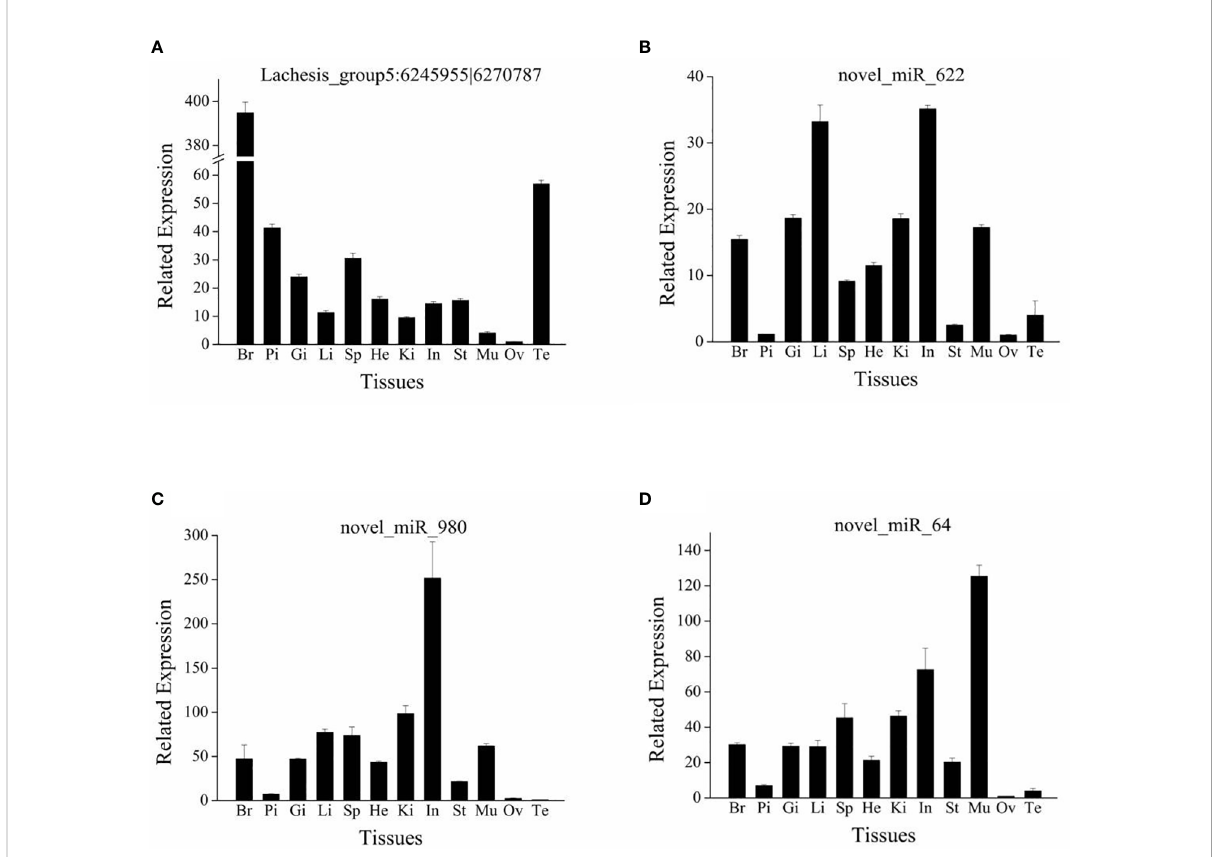
FIGURE 7 Tissue distribution of circRNA Lachesis_group5:6245955|6270787 (A) and three miRNAs novel_miR_622 (B) , novel_miR_980 (C) , and novel_miR_64 (D) . Br, brain; Pi, pituitary; Gi, gill; Li, liver; Sp, spleen; He, heart; Ki, kidney; In, intestine; St, stomach; Mu, muscle; Ov, ovary; Te, testis. Data are expressed as the mean value ± SEM (n =